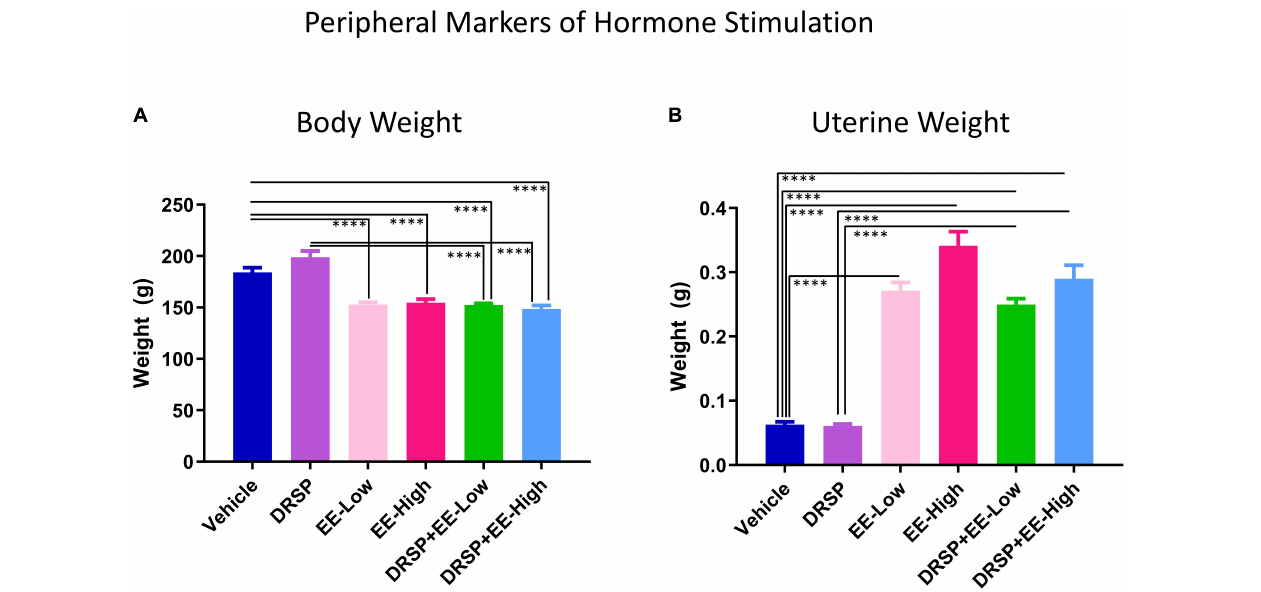
FIGURE 7 | Experiment 2 Body weight and uterine weight. All subjects were ovariectomized. (A) Rats treated with EE alone and in combination with drospirenone weighed significantly less than rats without hormone treatment. Rats treated with drospirenone weighed more than those that received drospirenone plus EE at a low or high dose. (B) Uterine weights from rats treated with EE weighed significantly more at euthanasia compared to rats without hormone treatment. Rats treated with drospirenone had lower uterine weights compared to rats treated with a combination of drospirenone and EE, but did not differ from rats without hormone treatment. ∗∗∗∗ p < 0.0001. Vehicle n = 10, DRSP n = 10, EE-Low n = 10, EE-High n = 10, DRSP + EE-Low n = 10, and DRSP + EE-High n =